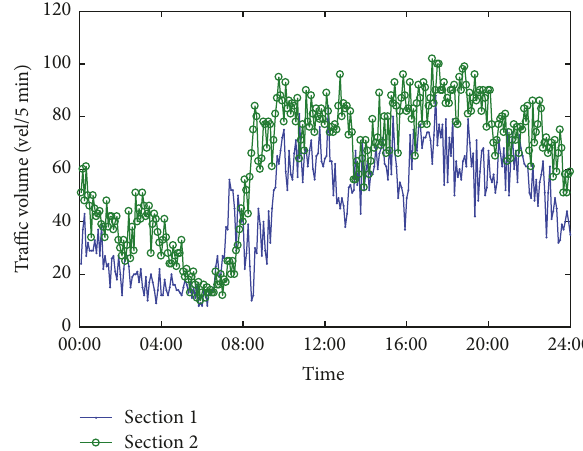
Figure 10: Traffic volume data from two adjacent sections in a lane of the urban arterial road.